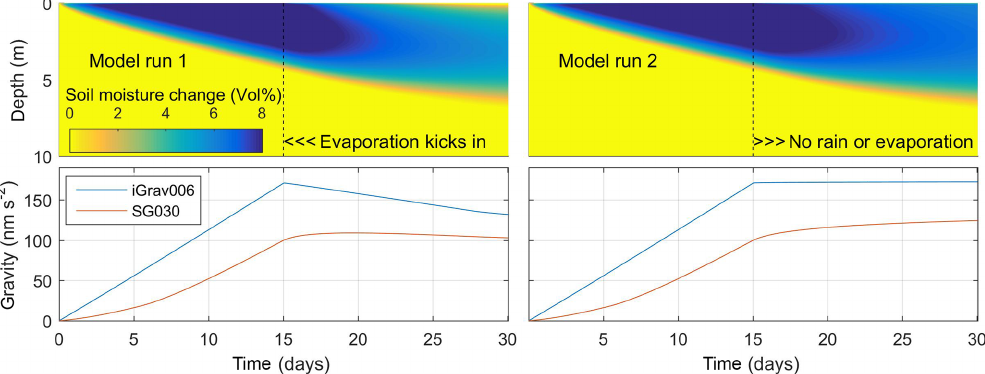
Figure 9. Simulated profile soil moisture changes (upper plots) and gravity response for SG030 and iGrav006 at Wettzell (lower plots) for two model experiments, both with artificial rainfall during the first 15 days and evaporation during the second 15 days (model run 1